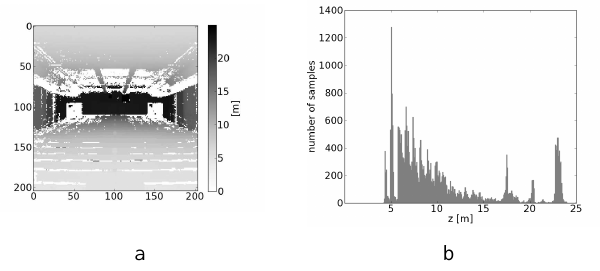
Figure 6. Mean depth: a) gray-coded image, b) histogram.